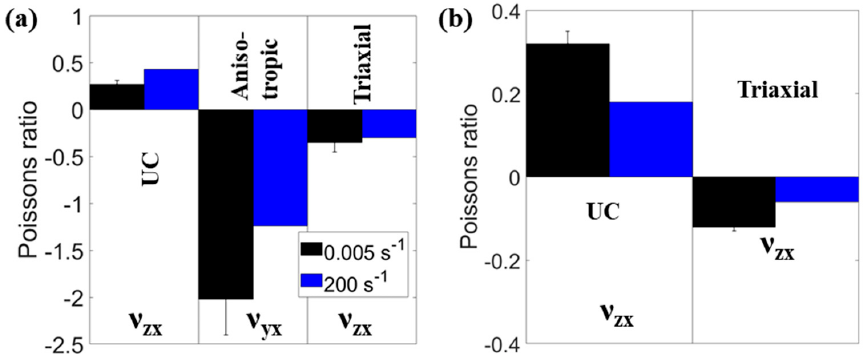
Figure 5. ( a,b ) Mean Poisson’s ratios of ( a ) open cell foams; ( b ) closed cell foams at applied strain rates of 0.005 s − 1 and 200 s − 1 , measured to 2% compression. Error bars show 1 standard deviation.